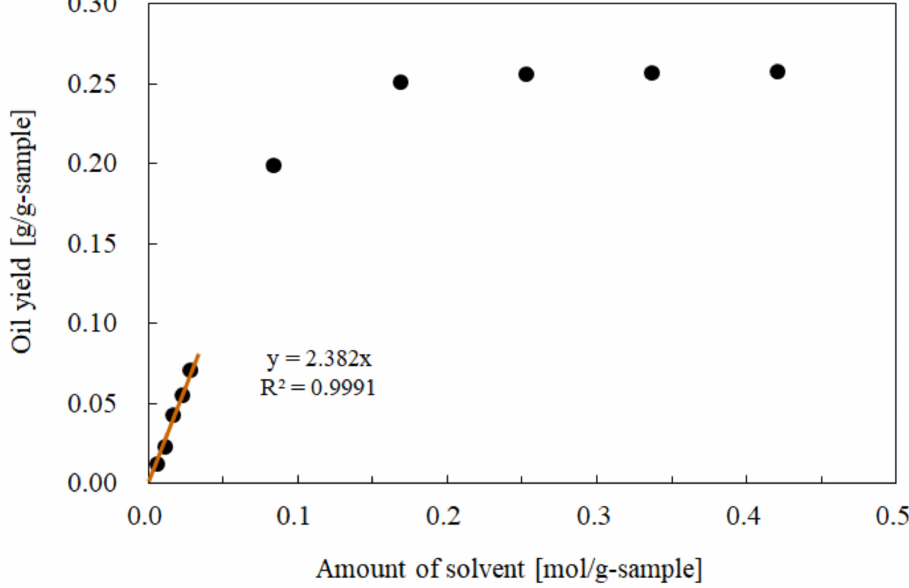
Figure 6. Determination of the oil solubility in CO 2 -expanded hexane at 25 ◦ C, 5.1 MPa, and with a CO 2 mole fraction of